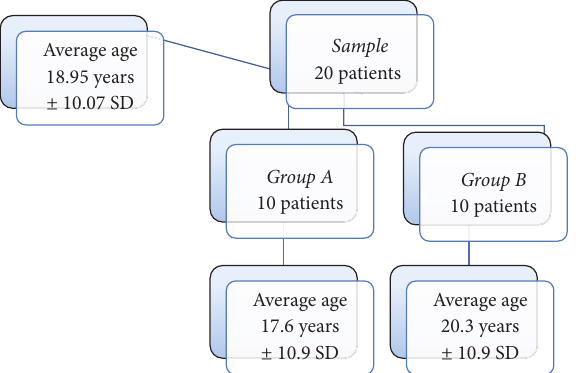
Figure 2: Stratification of the sample by